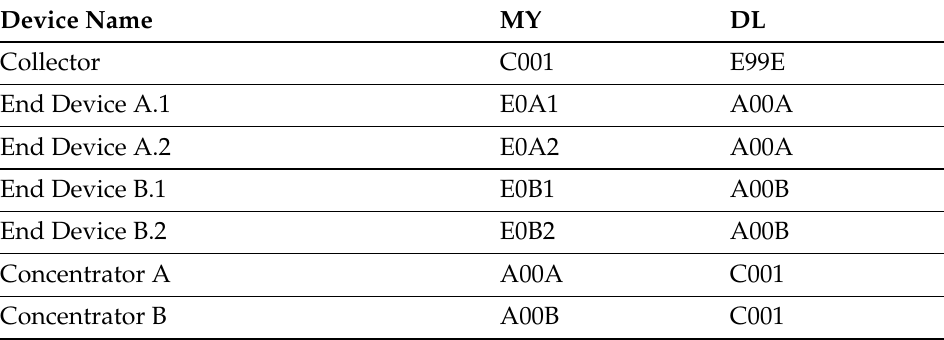
Table 2. XBee MY and DL